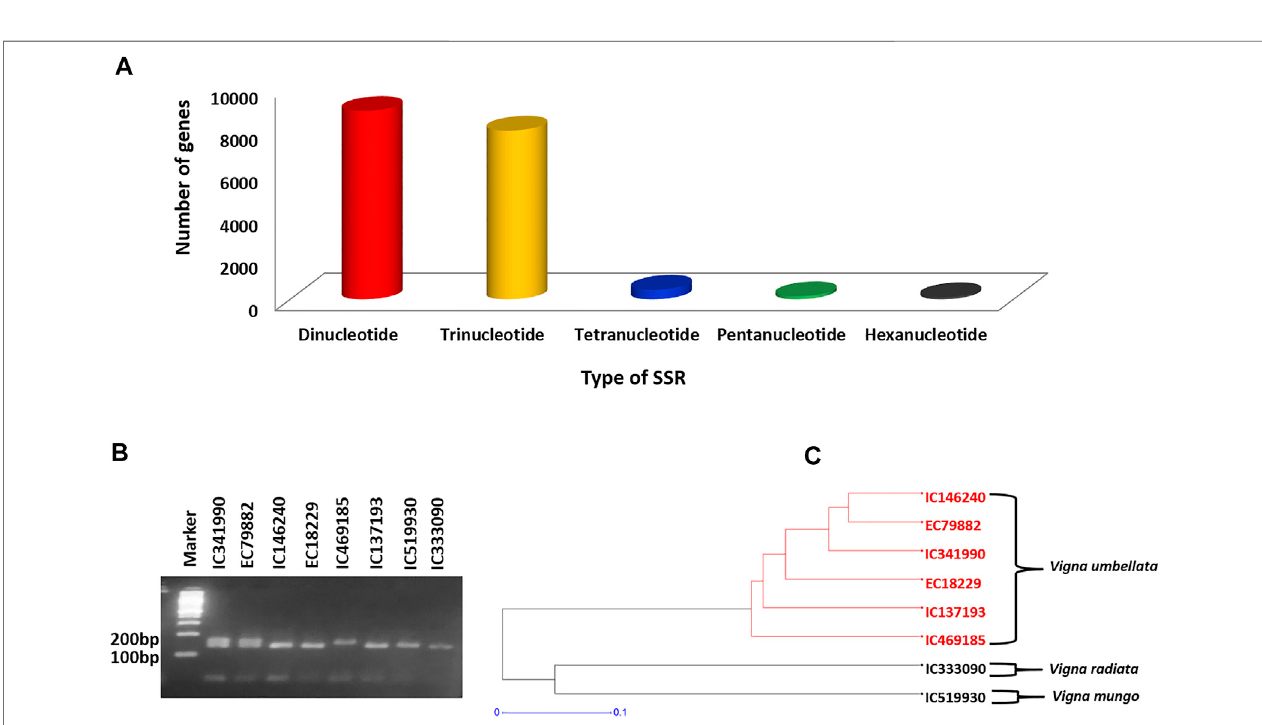
FIGURE 10 | (A) Bar diagram representing the type and frequency of SSRs identi fi ed in ricebean using assembled transcripts. (B) SSR13 polymorphism on selected eight accessions of Vigna species. (C) Dendrogram representing the relationship distance among the eight accessions.